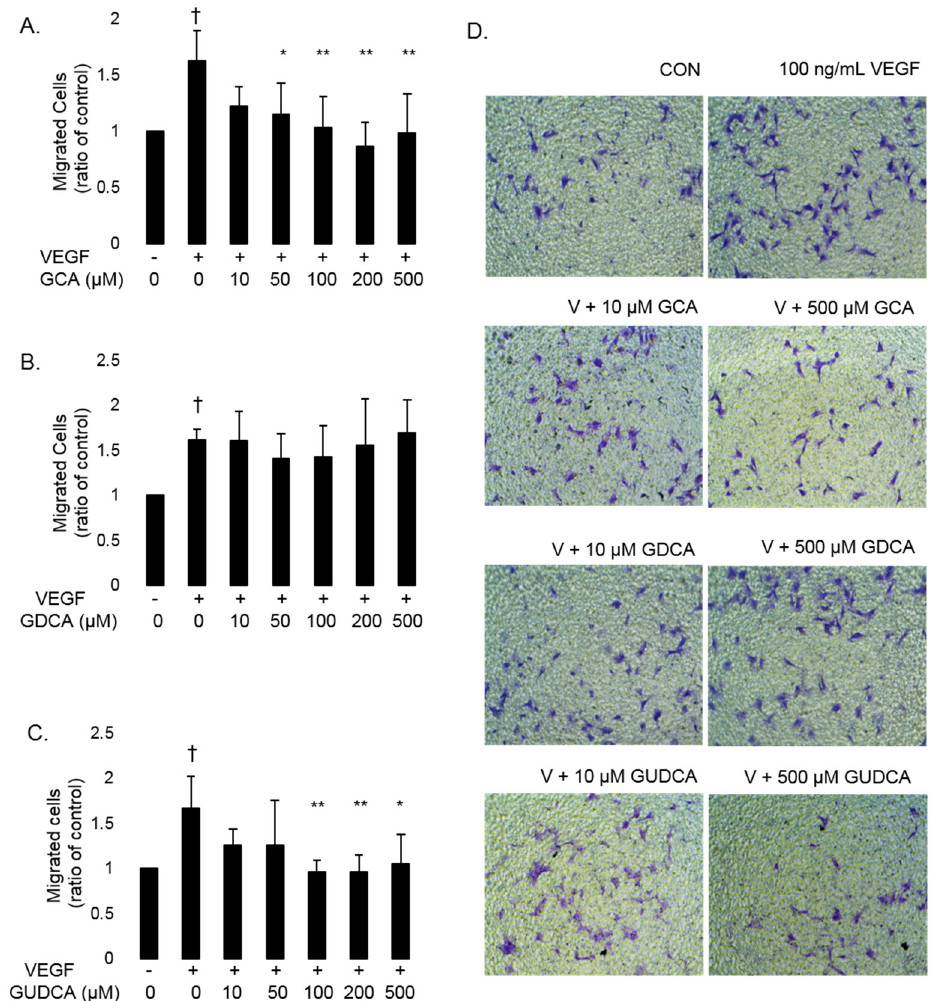
Figure 3. GCA and GUDCA inhibit VEGF-induced CEC migration. RF/6A cell migration was induced by treating cells with 100 ng/mL VEGF (V). Cells were treated with GCA, GDCA, or GUDCA (10, 50, 100, 200, or 500 µM) to evaluate their ability to inhibit cell migration. The number of migrated cells were counted from three standard fields and normalized to the average number of migrated cells in the untreated control. ( A ) VEGF induced cell migration compared to untreated controls (†: p = 0.0025). GCA did not inhibit migration at 10 µM and significantly inhibited VEGF-induced cell migration at 50, 100, 200, and 500 µM. ( B ) VEGF induced migration compared to untreated controls (†: p = 5.64 × 10 − 5 ). GDCA did not inhibit migration at any concentration tested. ( C ) VEGF induced migration compared to untreated controls (†: p = 0.0056). GUDCA did not inhibit migration at 10 or 50 µM and inhibited VEGF-induced migration at 100, 200, and 500 µM. Data are presented as mean ± standard deviation ( n = 6). *: p < 0.05; **: p < 0.01 for bile acid-treated cells compared to VEGF-treated cells. ( D ) Representative images of cell migration of untreated controls (CON), cells treated with 100 ng/mL VEGF (V), and cells treated with VEGF plus 10 µM and 500 µM concentrations of GCA, GDCA, and GUDCA.